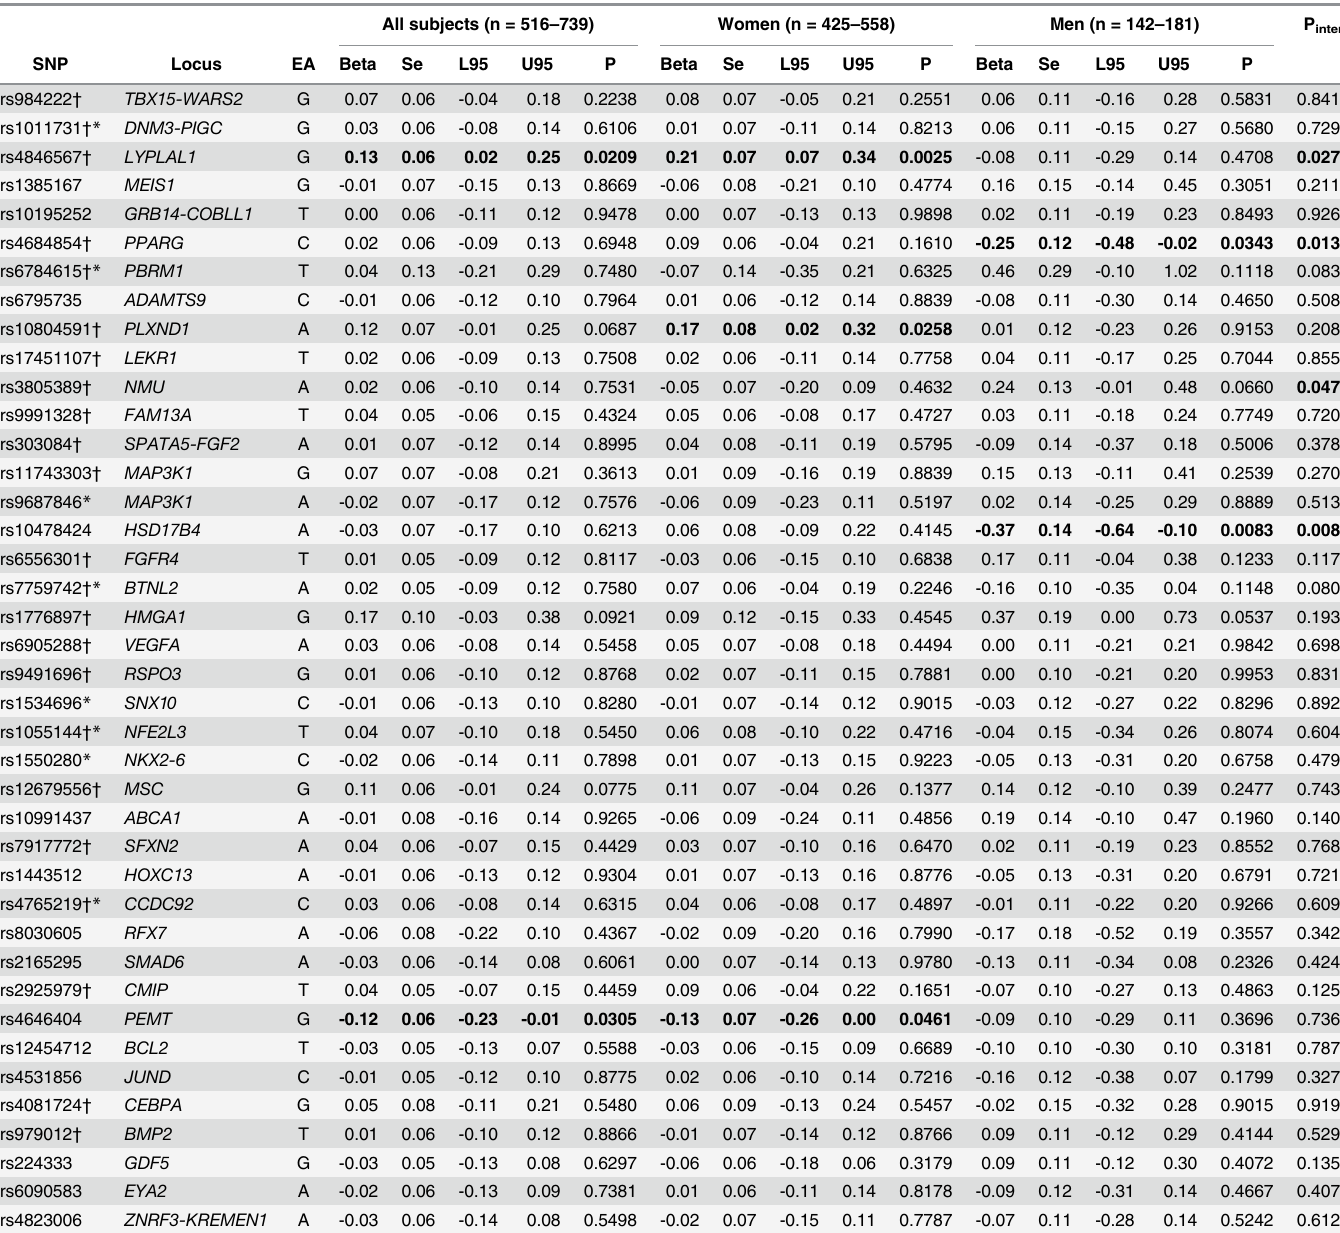
Table 6. Effect of SNPs tagging central obesity-associated loci on